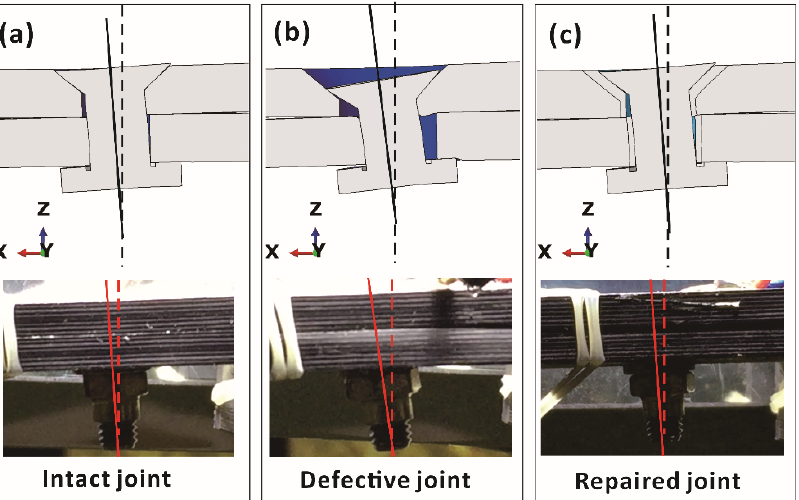
Figure 12. Numerical and experimental local deformations of bolts subjected to the same applied load (9 kN) for ( a ) intact, ( b ) defective and ( c ) repaired joints.